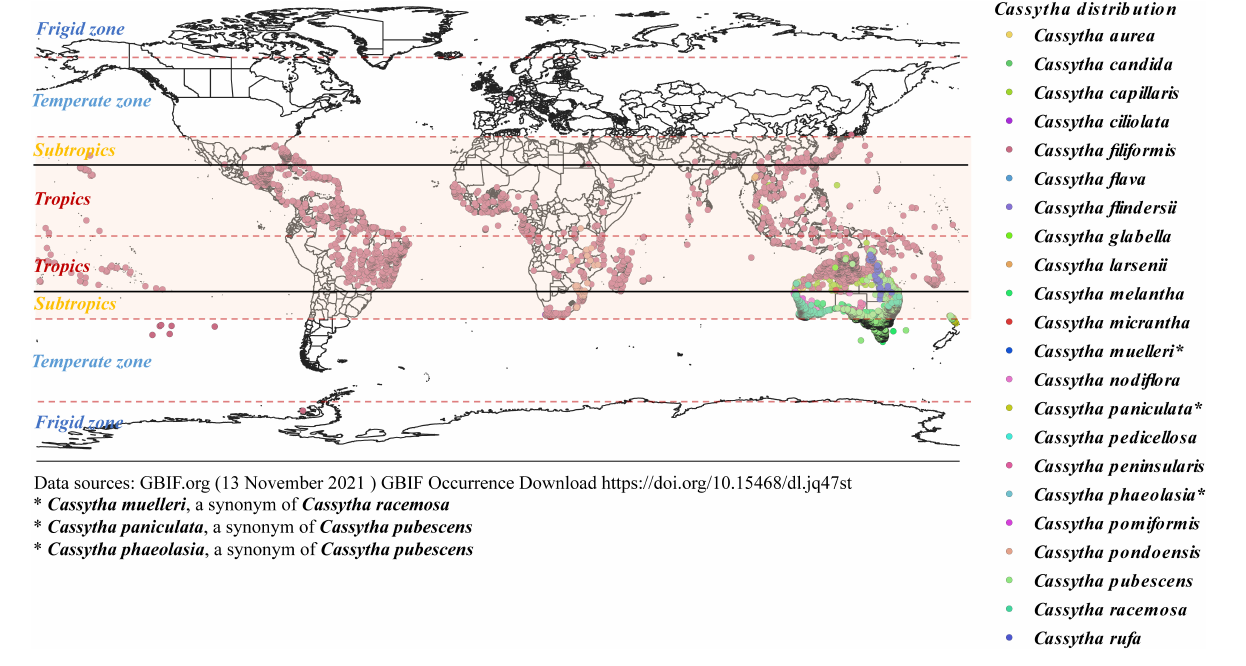
Frontiers in Plant Science |